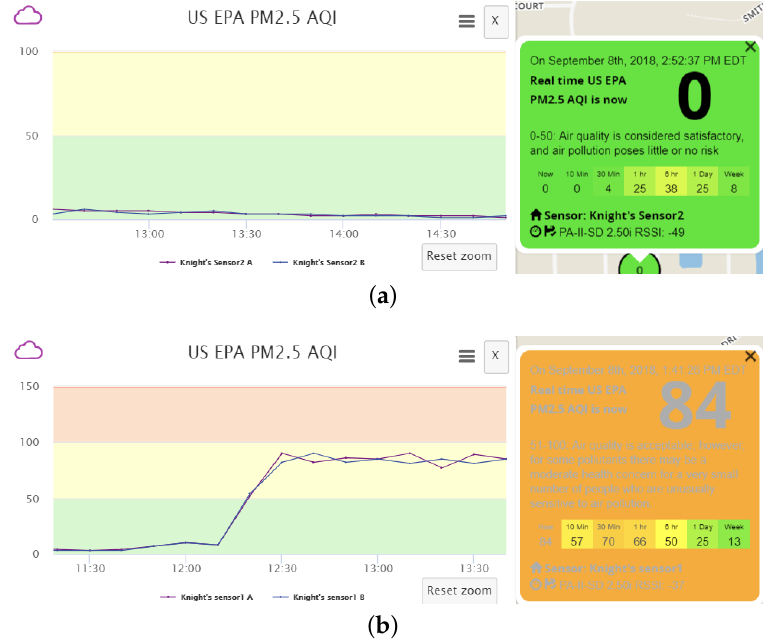
Figure 6. AQI fluctuation for Scenario B. ( a ) Before data pollution; ( b ) After data